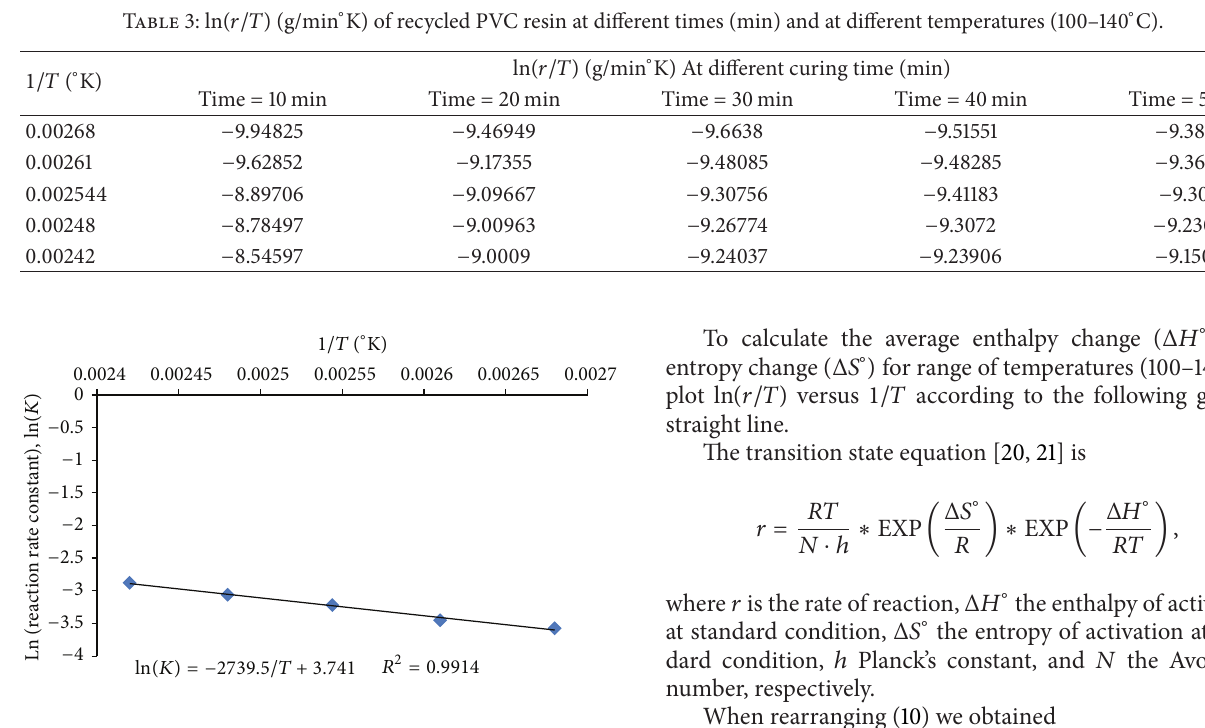
Figure 3: The ln (𝐾) versus (1/𝑇)( ∘ K ) of PVC resin at different temperature (100–140 ∘